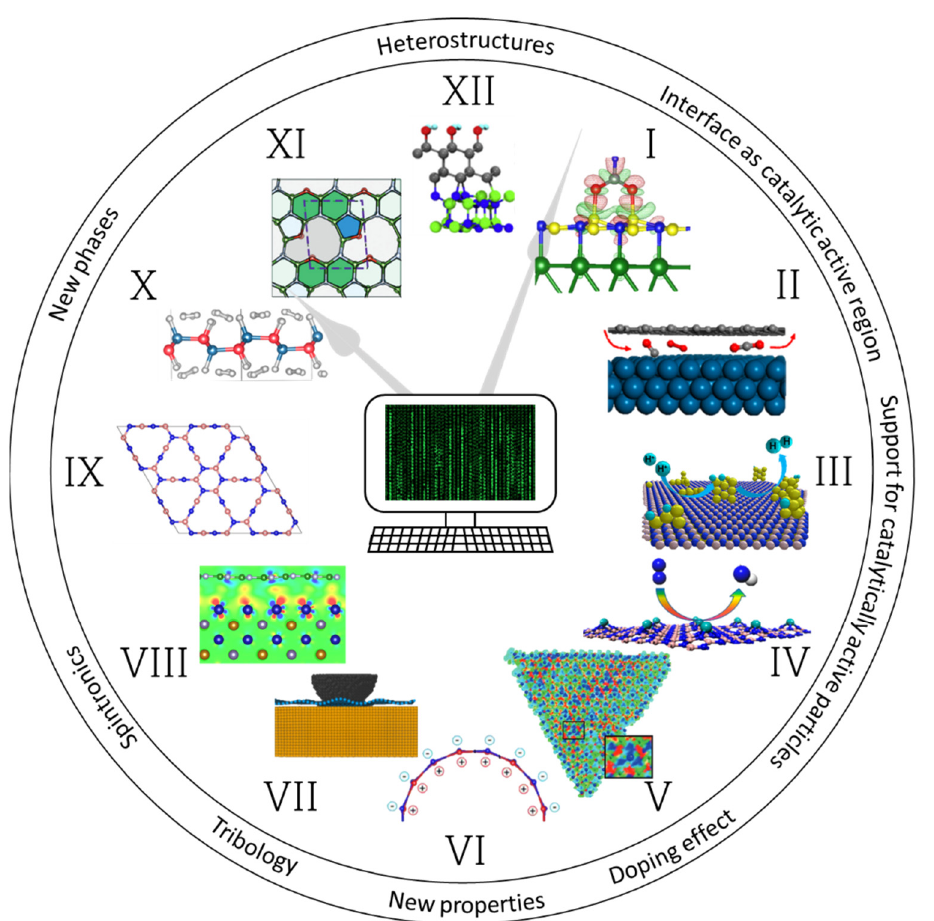
Figure 7. Schematics of various directions of modeling BN nanostructures (I, II— h -BN/metal interface as a catalytic center; III, IV— h -BN substrate for catalytically active NPs; V— h -BN doping; VI–